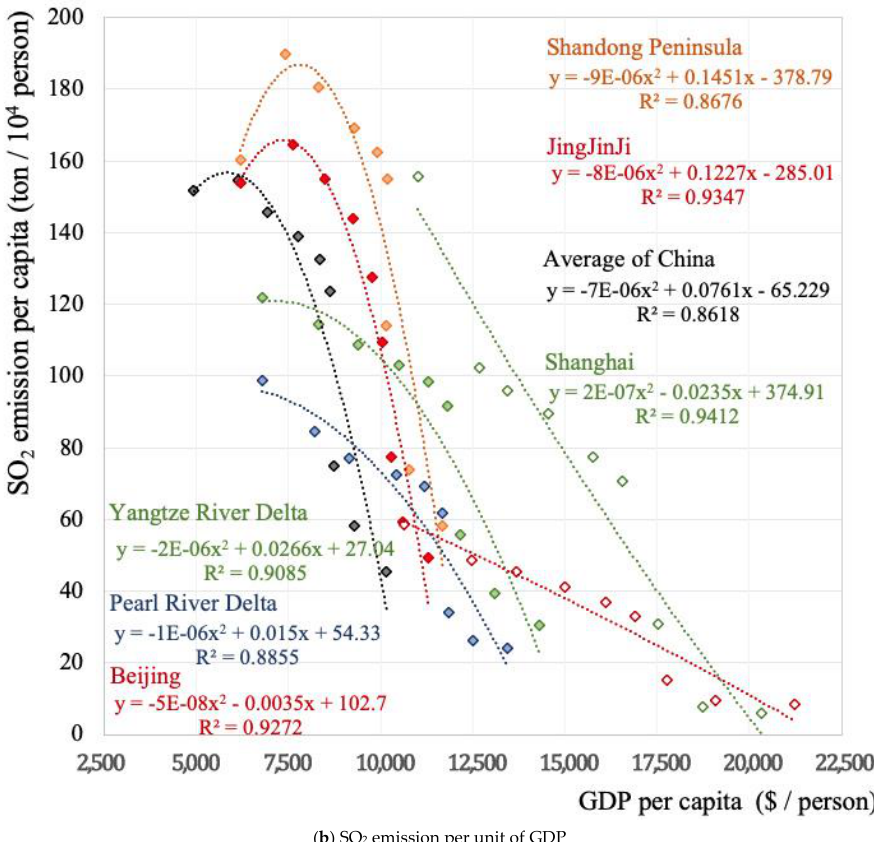
Figure 7. The trend of environmental pollution in China (each point represents an average value of the variable for the cities in that group for each year in the data set). (Data source: China Statistical Yearbook 2011 – 2019 [36]).